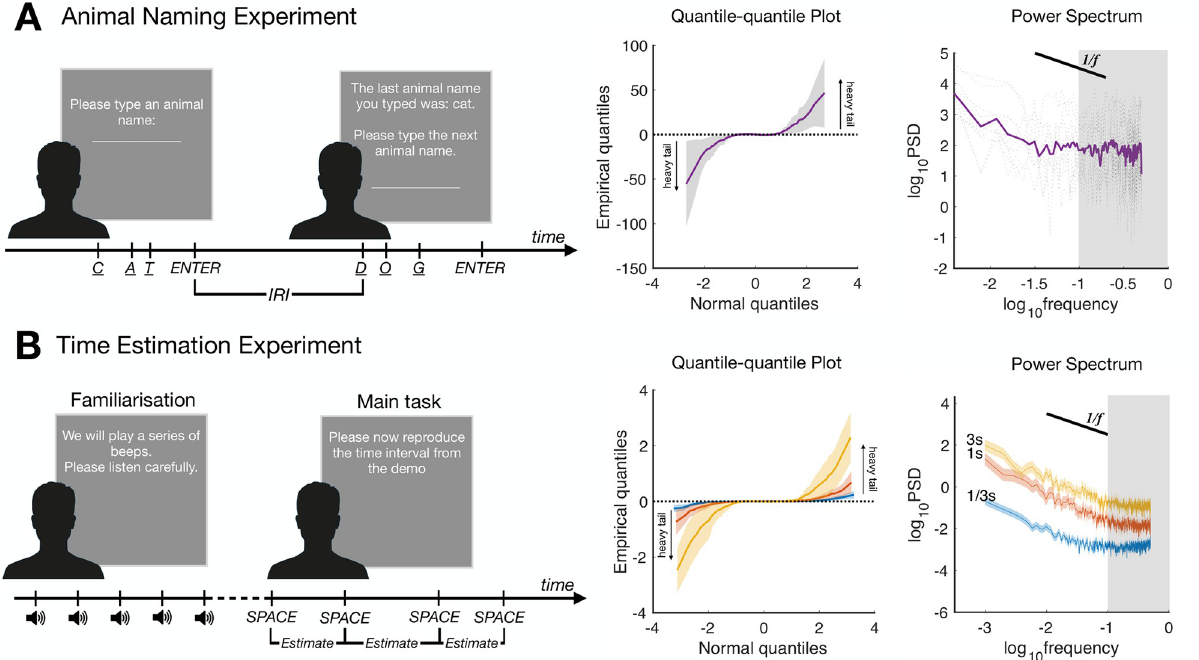
Fig 1. Experiments and results. (A) Animal naming experiment. (B) Time estimation experiment. Within each row from left to right, there are illustrations of the experimental procedure, quantile-quantile plots of successive changes in IRI or time estimates to test for heavy tails (95% CI shaded around means and the horizontal dashed lines denoting the Gaussian distribution), and power spectra to test for 1/ f noise (fitted at frequencies less than 0.1, 95% CI shaded around